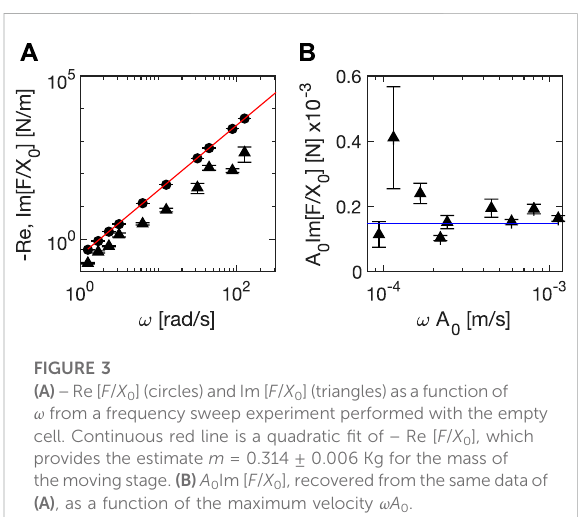
FIGURE 3 (A) − Re[ F / X 0 ](circles)andIm[ F / X 0 ](triangles)asafunctionof ω from a frequency sweep experiment performed with the empty cell. Continuous red line is a quadratic fi t of − Re [ F / X 0 ], which provides the estimate m = 0.314 ± 0.006 Kg for the mass